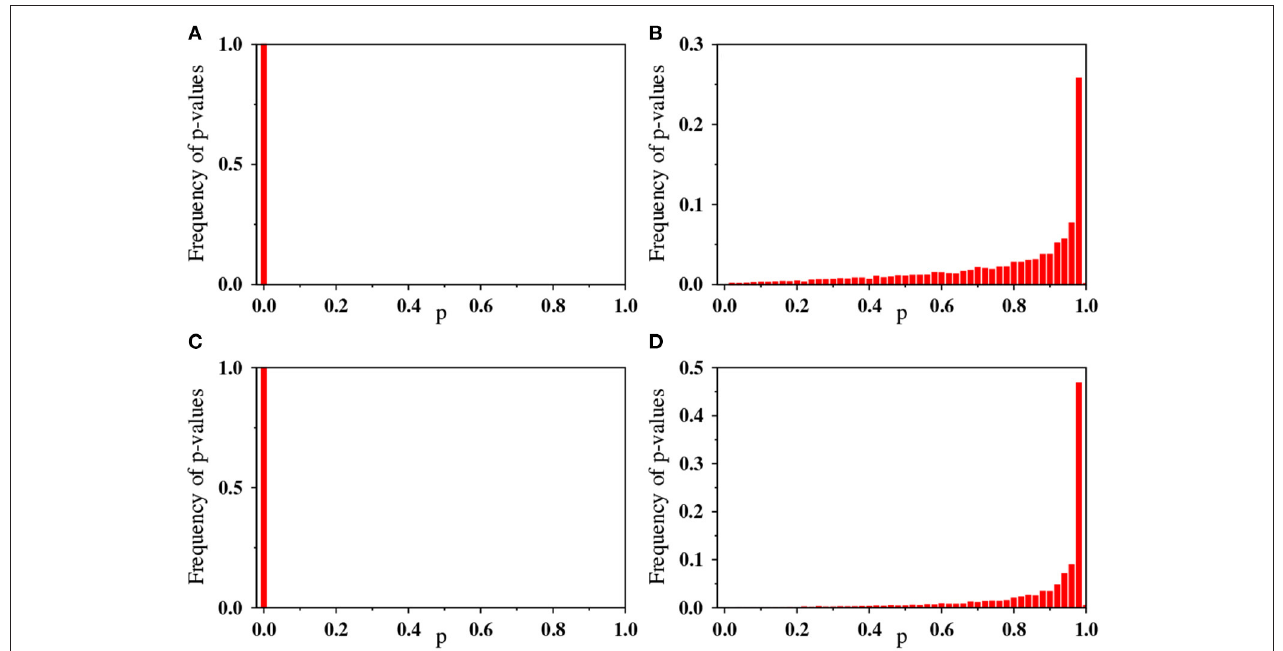
FIGURE 6 | Normalized frequency distribution of the p -values computed from the KS test statistic between two degree distributions: (A,C) Comparison of degree distributions for the original time series and its shuffled ones. (B,D) Comparison of degree distributions for two shuffled time series obtained from a given original time series. In each panel, the data is obtained from 10 4 shuffled series. The upper and lower panel correspond to the time series of Tohoku 1 and Cascadia, respectively.